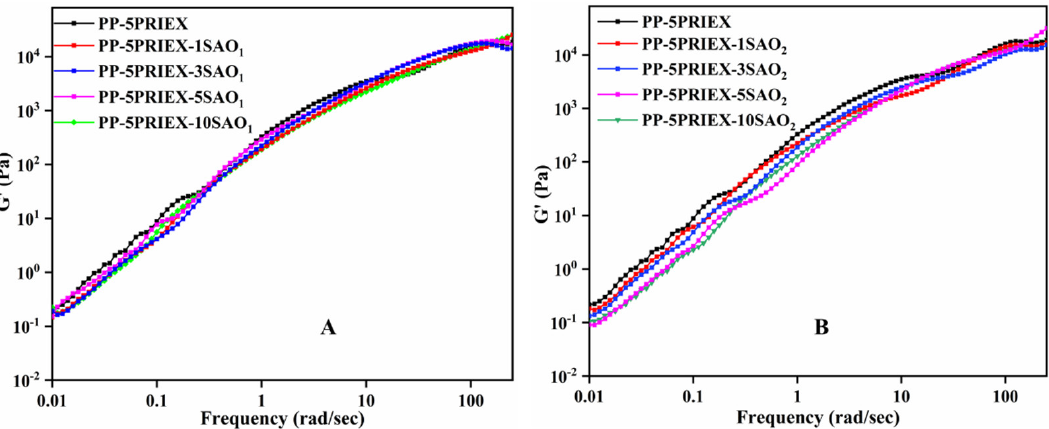
Figure 5. The storage modulus of PP/PRIEX / SAO 1 ( A ) and PP/PRIEX / SAO 2 ( B ) composites .